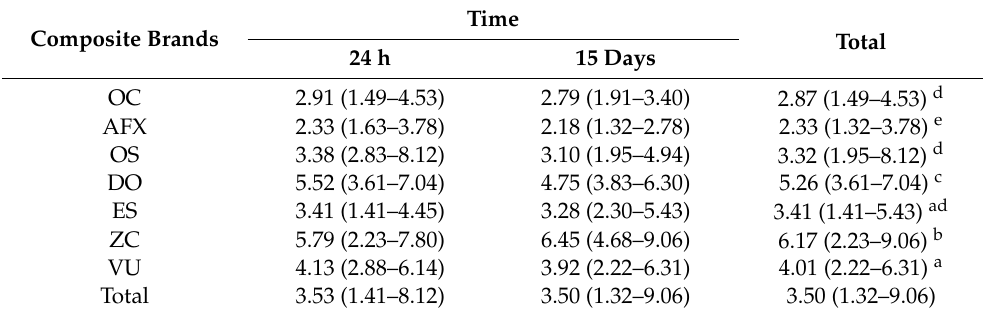
Table 7. Multiple comparison of E M (gPa) values of the composites according to time intervals. Composite